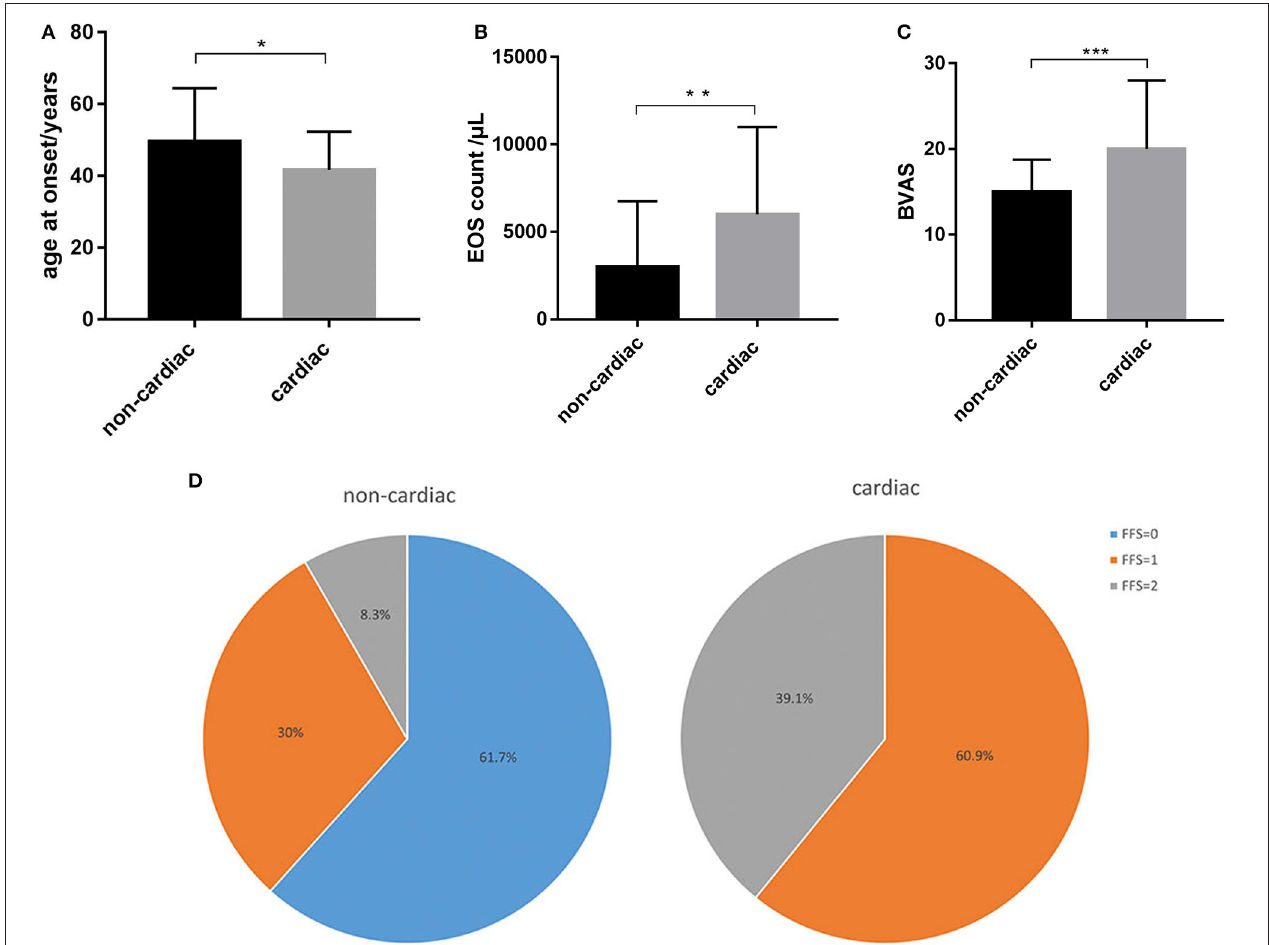
FIGURE 1 | Distinct characteristics between EGPA patients with and without cardiac involvement. (A) EGPA patients with cardiac involvement had a younger age at onset than those without cardiac involvement. (B) Patients with cardiac involvement had higher eosinophil counts than those without cardiac involvement. (C) Patients with cardiac involvement had higher BVAS than those without cardiac involvement. (D) Patients with cardiac involvement had a poorer prognosis (FFS ≥ 1) than those without. * p < 0.05, ** p < 0.01, *** p < 0.001.